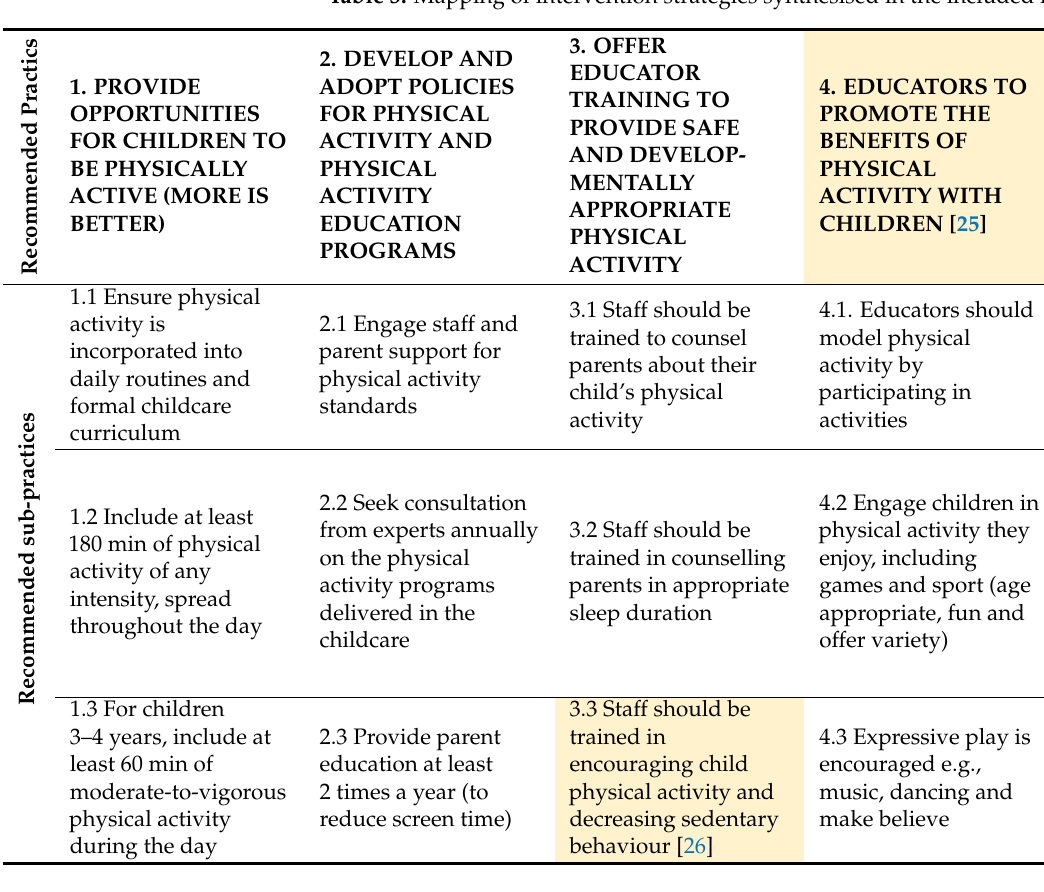
Table 3. Mapping of intervention strategies synthesised in the included reviews to the recommended practices